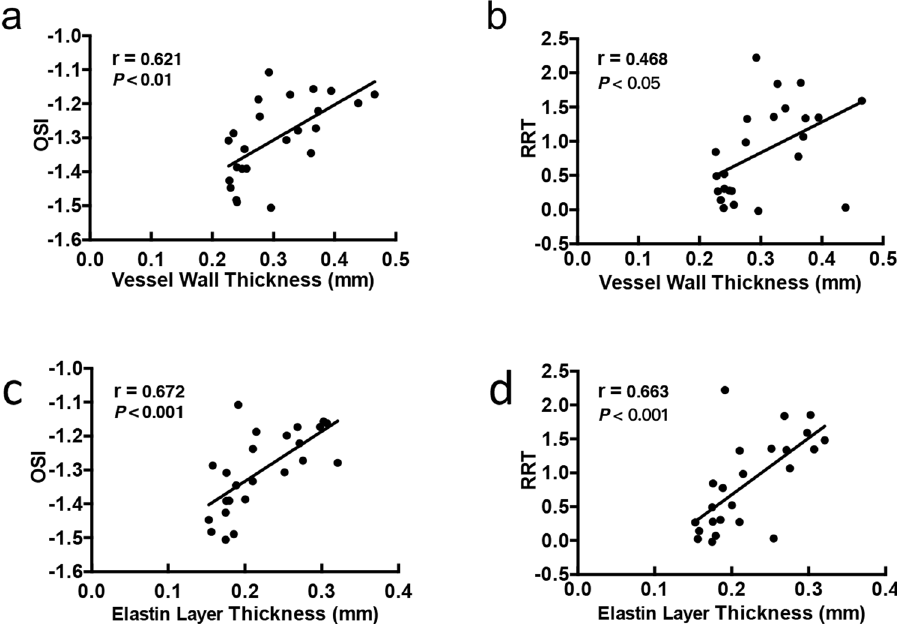
Figure 4. The correlations between haemodynamic parameters and vascular remodelling indicators in SHRs and WKYs. OSI and RRT were positively correlated to the vessel wall thickness ( a , b ) and to the elastin degradation layer thickness ( c , d ) near inner wall of aortic arch,